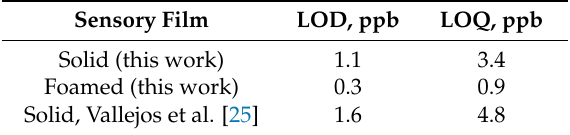
Table 2. Limit of detection (LOD) and limit of quantification (LOQ) values determined from titration curves of Hg(II) for solid and foamed films, compared to our previous results taken from reference [25]. Sensory Film LOD, ppb LOQ, ppb Solid (this work)